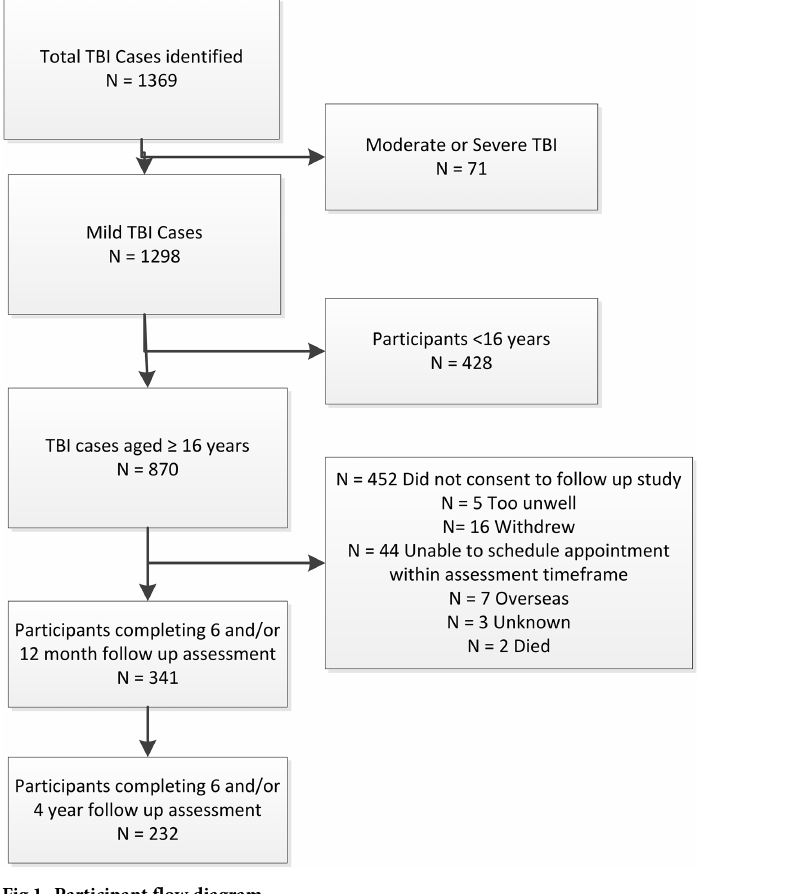
Fig 1. Participant flow